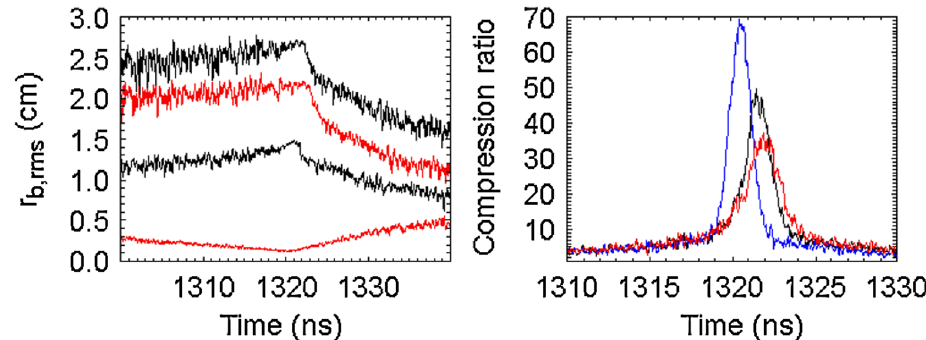
(cid:9) t (cid:10) (left, top profiles) and compression ratio I b (cid:6) (cid:1) 15 : 4 mrad (black) and (cid:1) 32 : 3 mrad (red). For reference, the completely r (cid:9) t (cid:10) (left, bottom profiles) and compression ratio I b